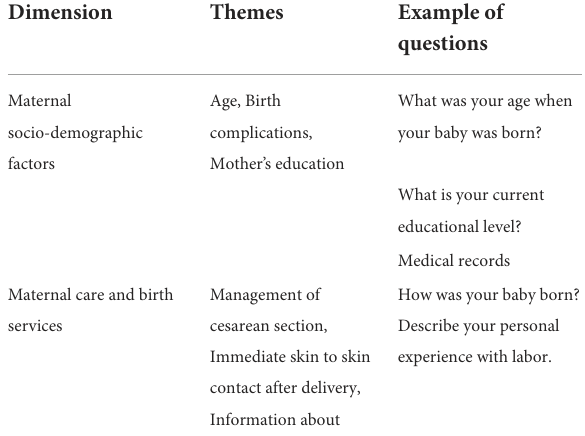
TABLE 2 Interview guide and coded dimensions.